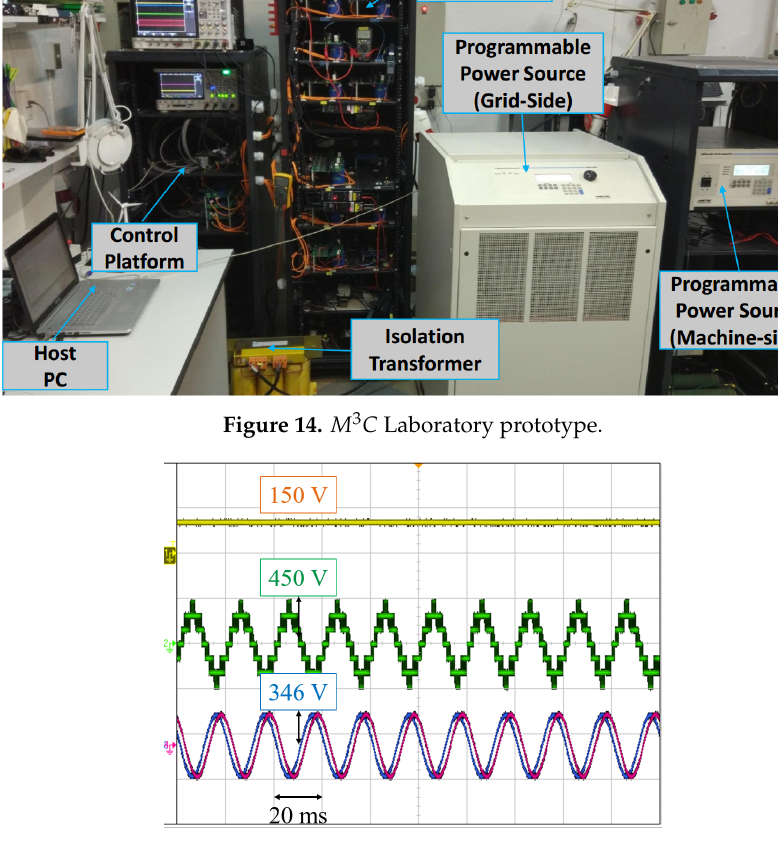
Figure 15. Experimental